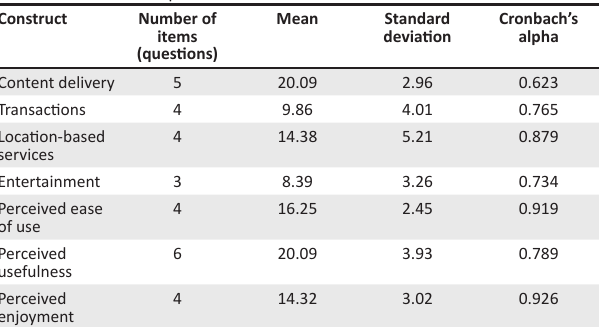
TABLE 2: Cronbach’s alpha